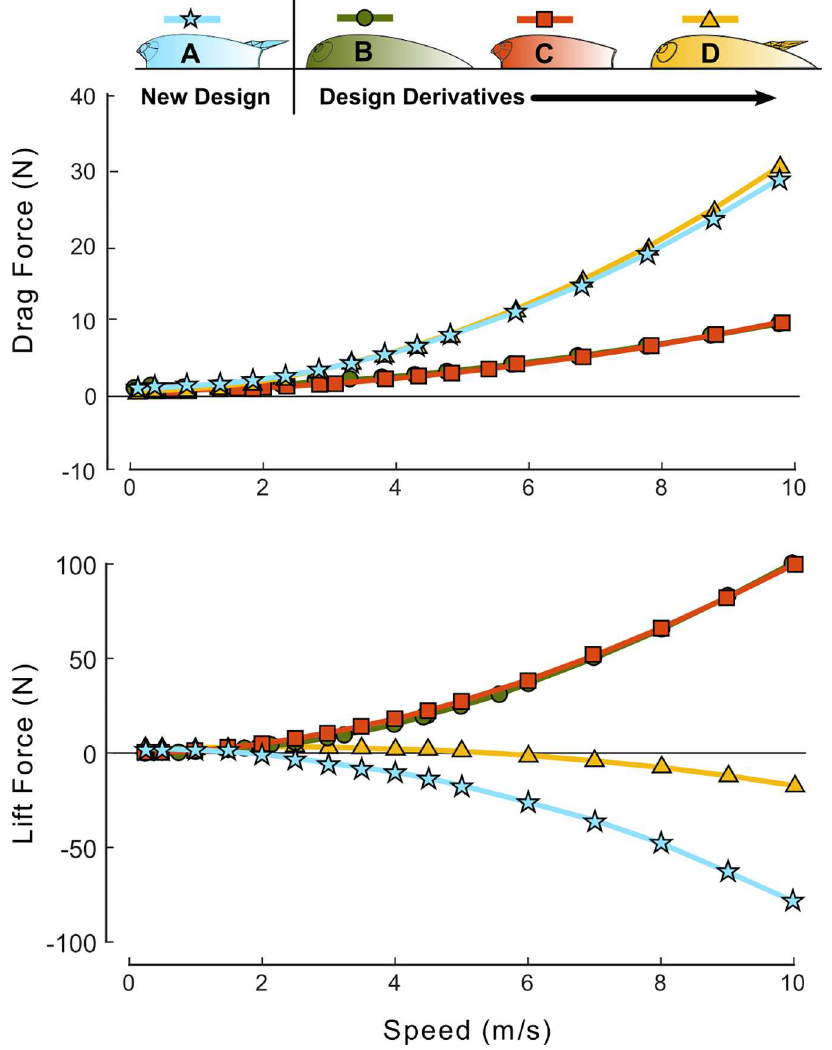
Fig 7. Net drag and lift forces for each tag design in variable-speed inline flow. At the higherspeeds the wings generatesa net downwardforce but also more drag. Less drag is created without the wing but the lift forces increasegreatly. Secondorder polynomial fits (solid lines) were used to interpolatebetweensimulation data points. Fitting parameters and R 2 values are presented in Table 3.